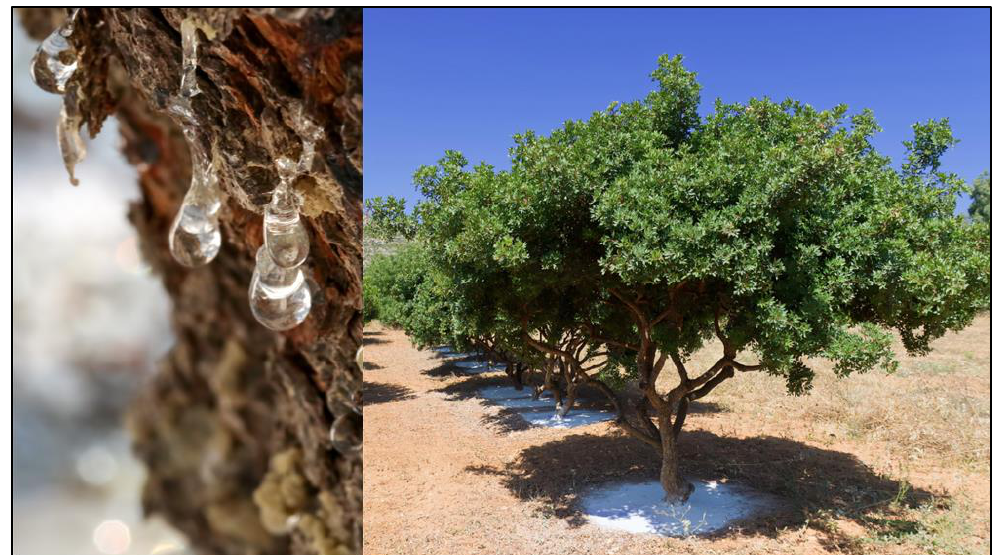
Figure 2. Mastic gum resin ( left ) and mastic trees ( right ).